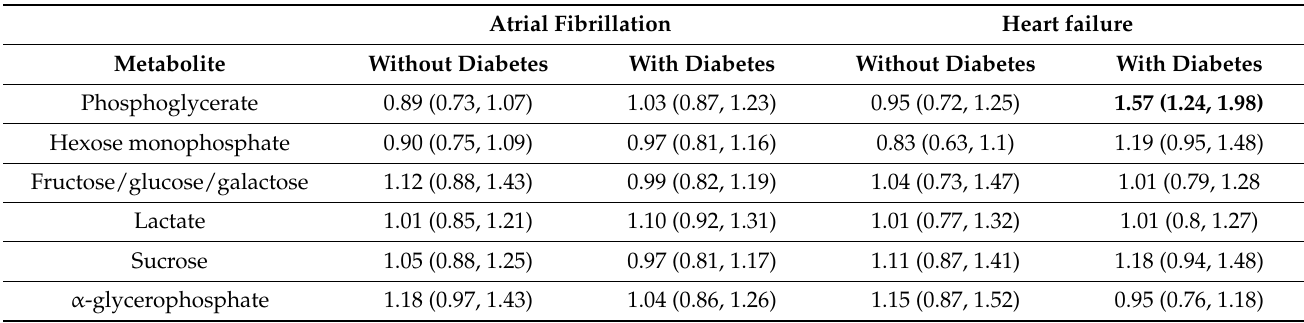
Table 4. Association between baseline plasma glycolysis species (per 1-SD increase) and other related metabolites, and incident atrial fibrillation and heart failure, by diabetes